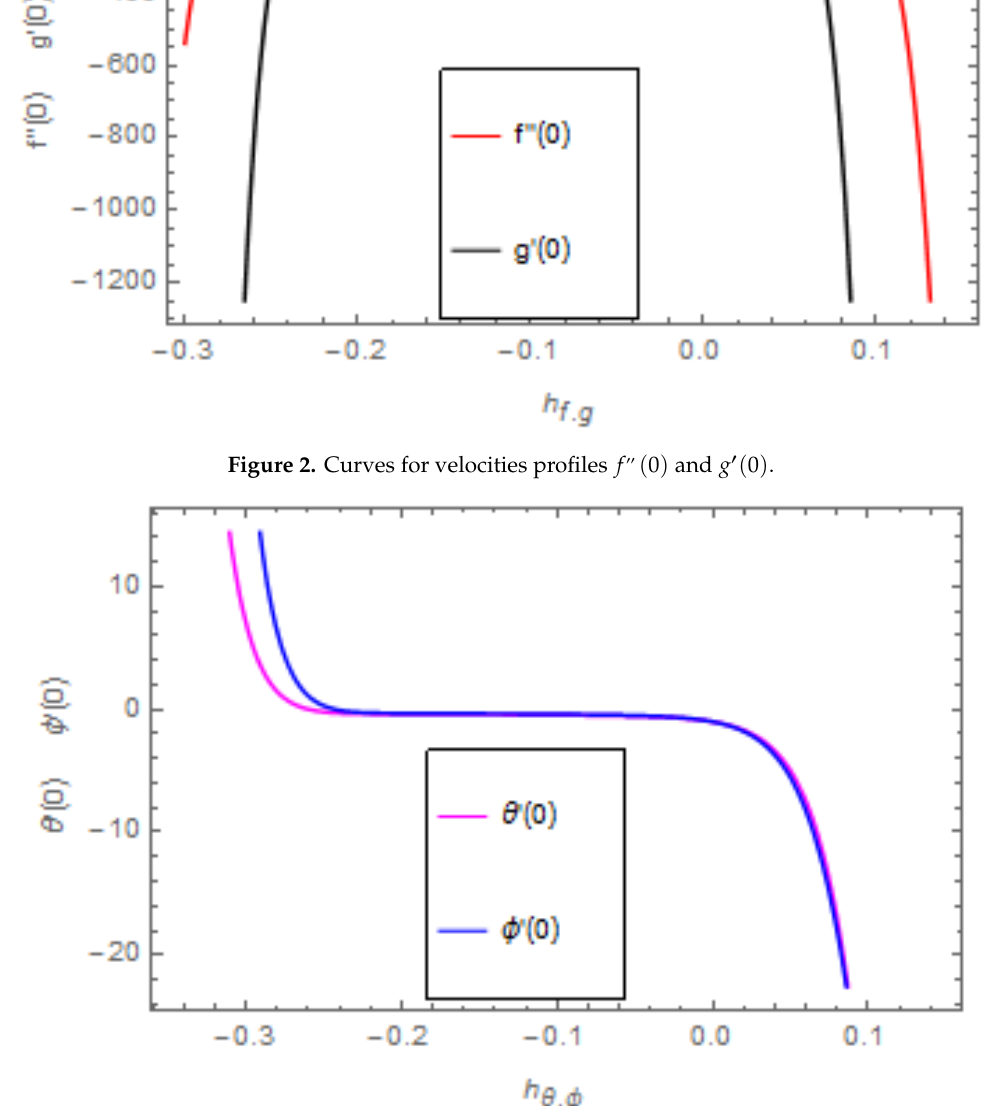
Figure 3. Curves for temperature and concentration profiles φ (cid:48) ( 0 ) and θ (cid:48) ( 0 )